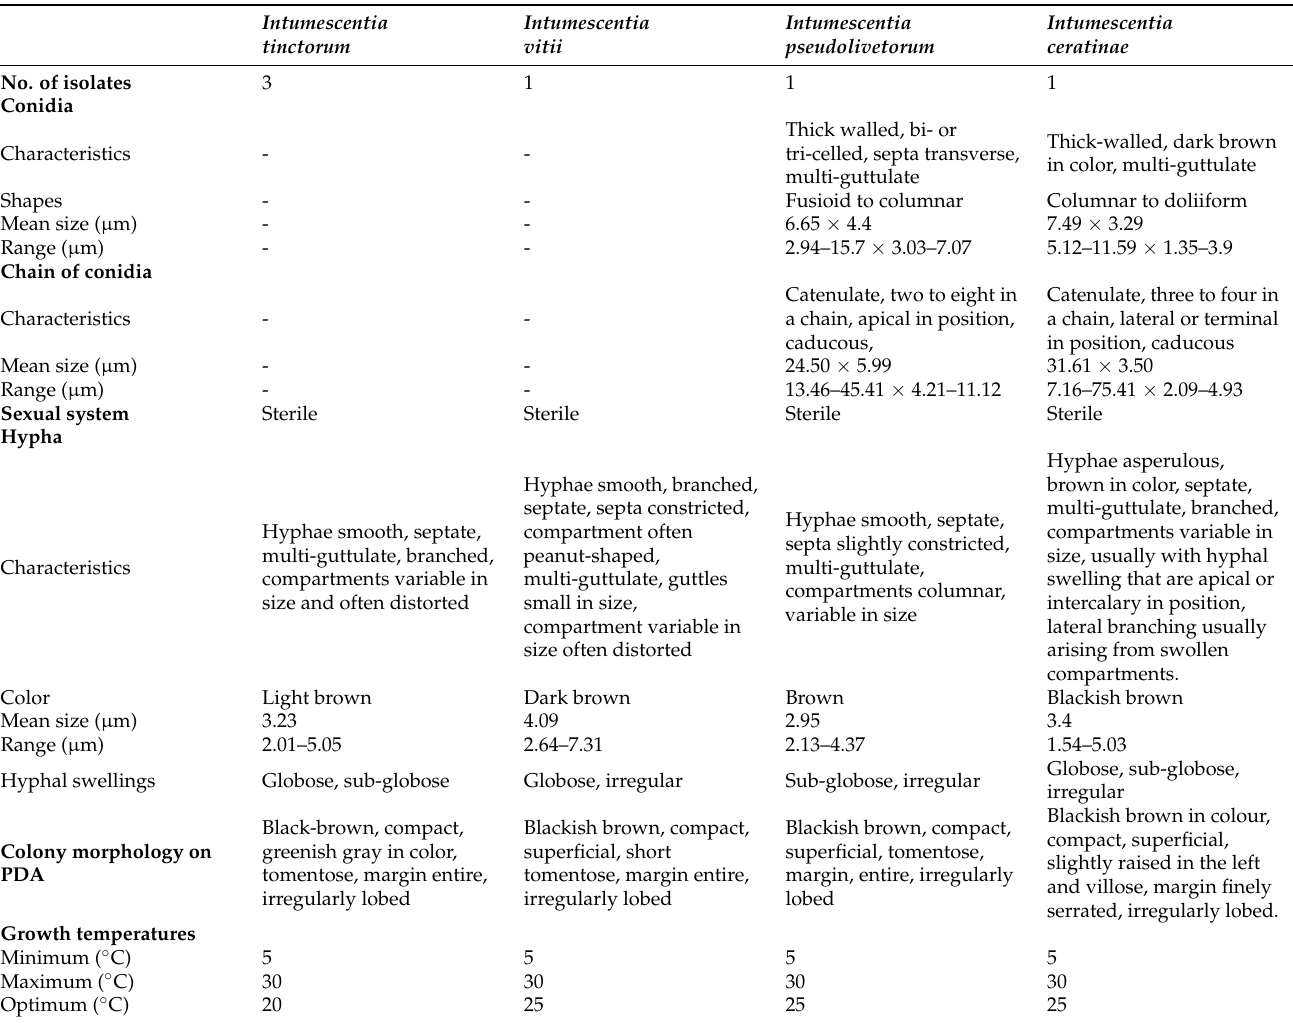
Table 1. Comparison of the morphological characters and growth rate of Intumescentia species recovered in this